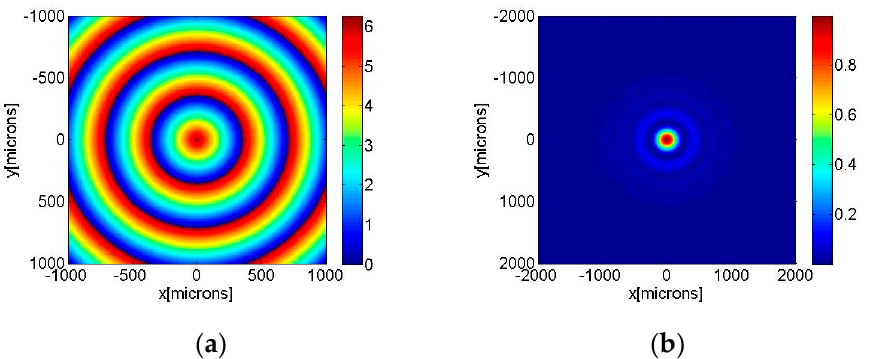
Figure 1. Zeroth-order axicon. ( a ) Numerical axicon of zero order with discrete profile (32 levels), ( b ) intensity of a Bessel–Gauss beam of zero order generated after the diffraction of a Gaussian beam on the axicon for z = 75 cm.